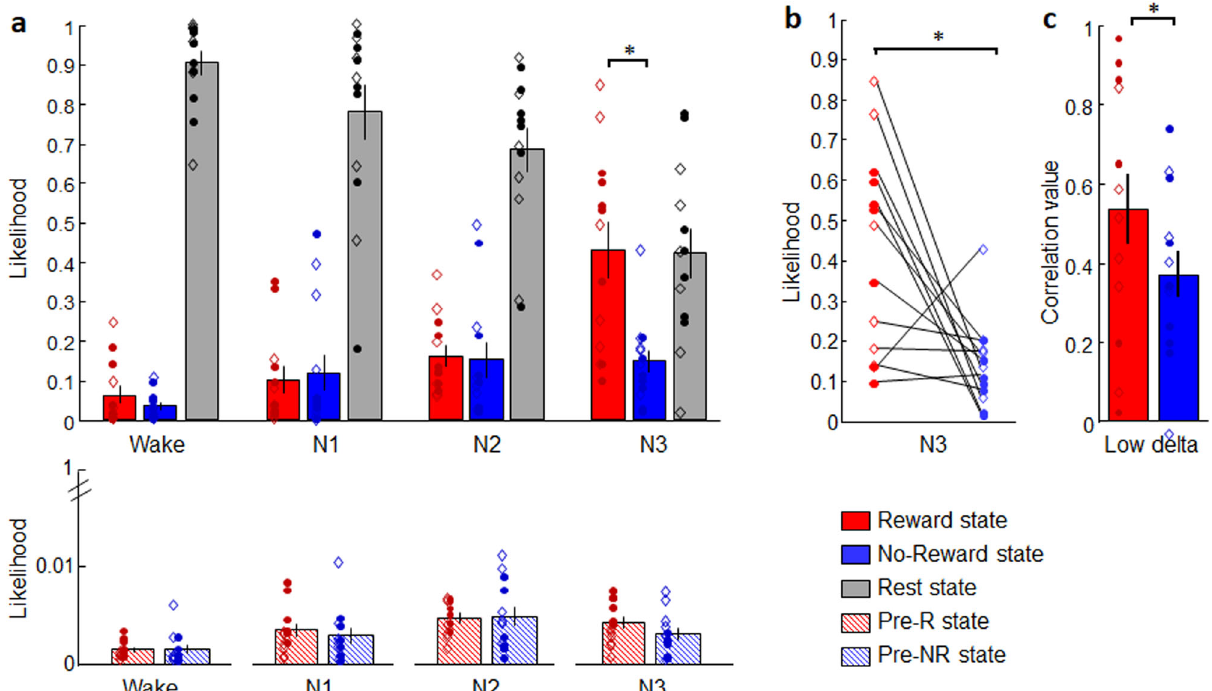
Fig. 3 Classi fi cation results ( N = 13). a Mean likelihood of Reward, No-Reward, Rest, pre-Reward (pre-R) and pre-No-Reward (pre-NR) brain states in each sleep stage, showing increased reactivation of the brain state associated with the rewarded game during N3. Asterisk represents p = 0.007 for repeated measures ANOVA with post-hoc t test (two-sided). b Individual data for the Reward and No-Reward state during N3 sleep. Asterisk represents p = 0.007 for t test (two-sided). c Correlation between time course of likelihood and low delta power (1 – 2 Hz) for the Reward and No-Reward states. Error bars represent SEM (Standard Error of the Mean); dots represent individual values for those participants won the face game and diamonds correspond to data from participants who won the maze game. Asterisk represents p = 0.03 for t-test (two-sided). W indicates Wake; N1, N2, N3 indicate N1, N2, N3 sleep stages respectively. Source data are provided as a Source Data fi